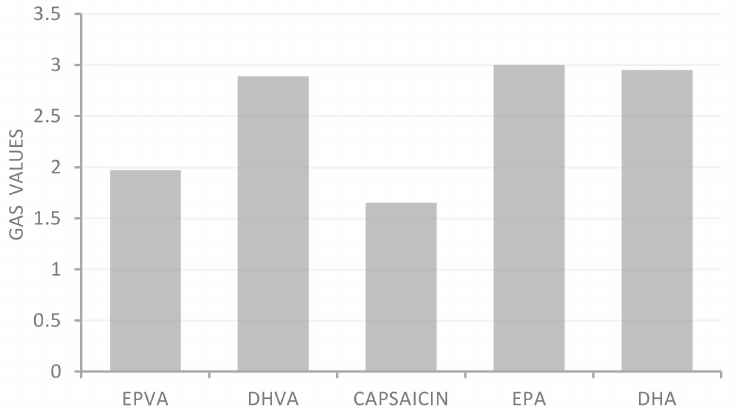
Figure 2. Global Antioxidant Score (GAS) values of n -3 PUFA-derived capsaicin